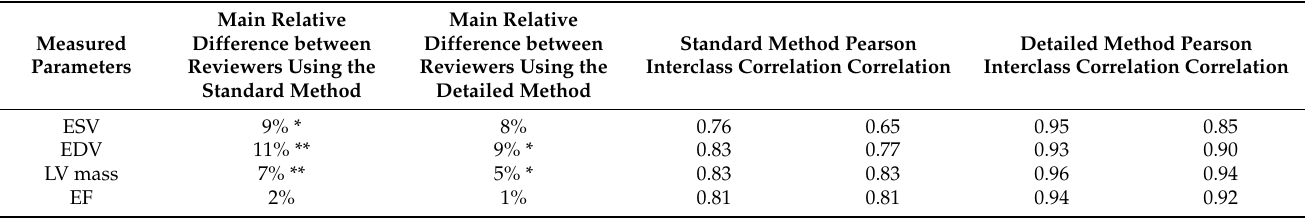
Table 4. Correlations in assessment of the pig LVV and contractility between two reviewers using the standard and detailed methods ( n =